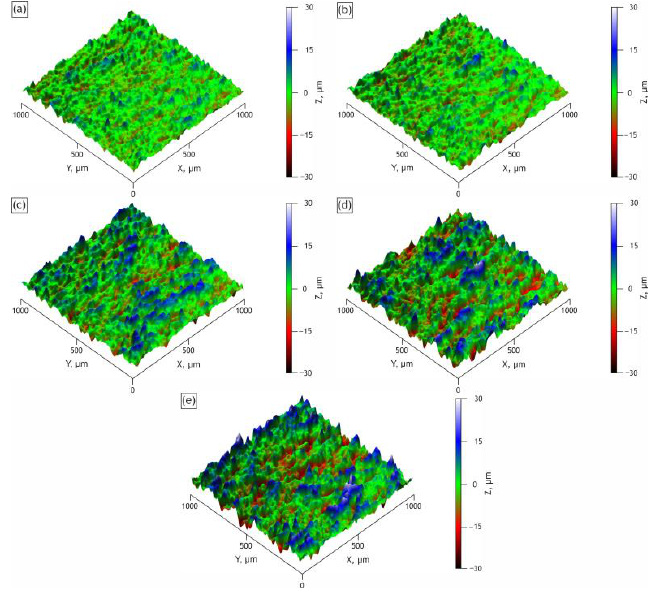
Figure 6. Surface topography of the H0 ( a ), H10 ( b ), H20 ( c ), H30 ( d ), H40 ( e ) samples.